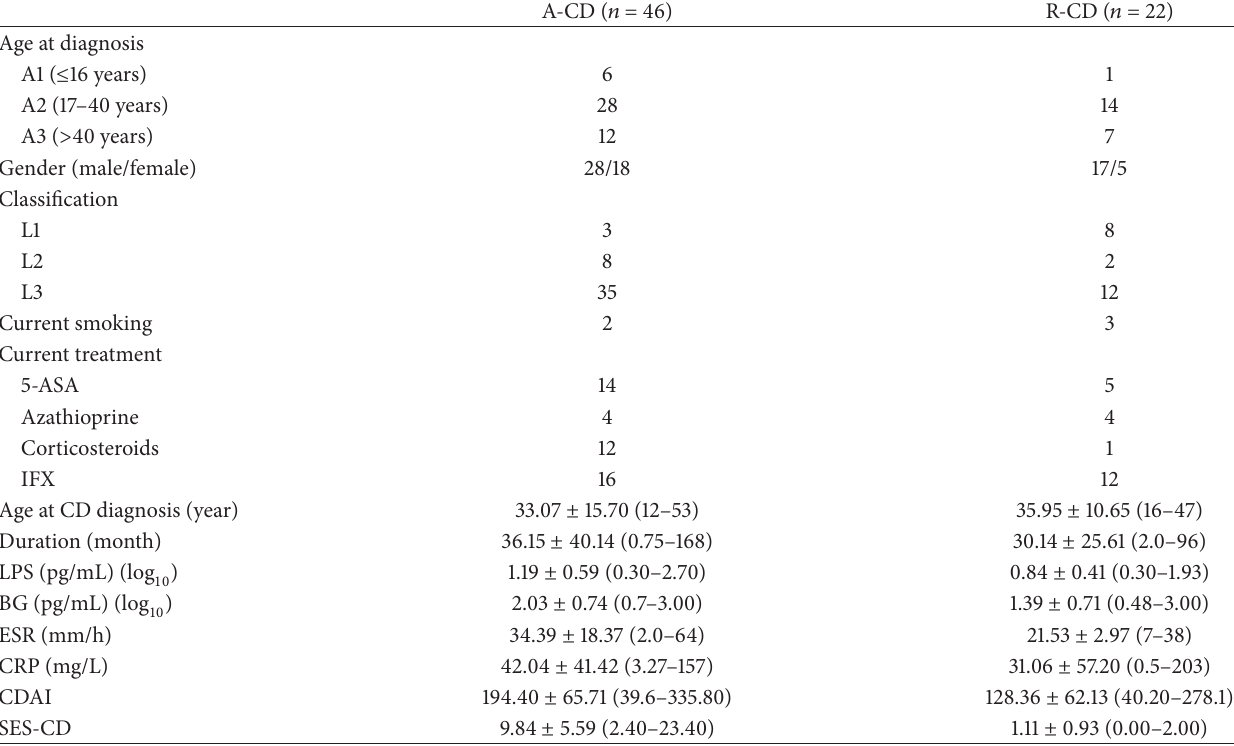
Table 1: Demographic characteristics and clinical features of the CD